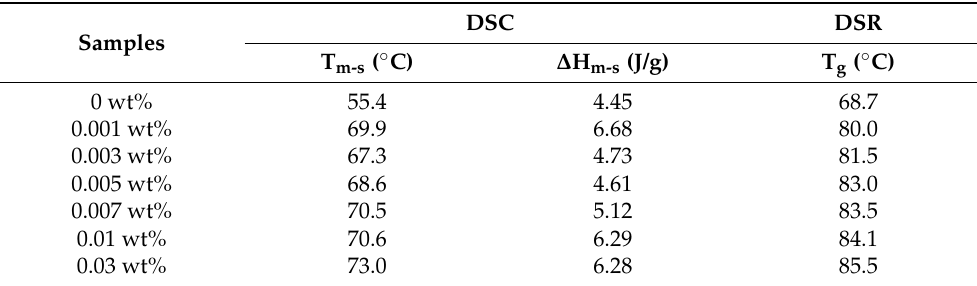
Table 2. Thermal properties and value of T g of WPU and its composites with different content of NGS.